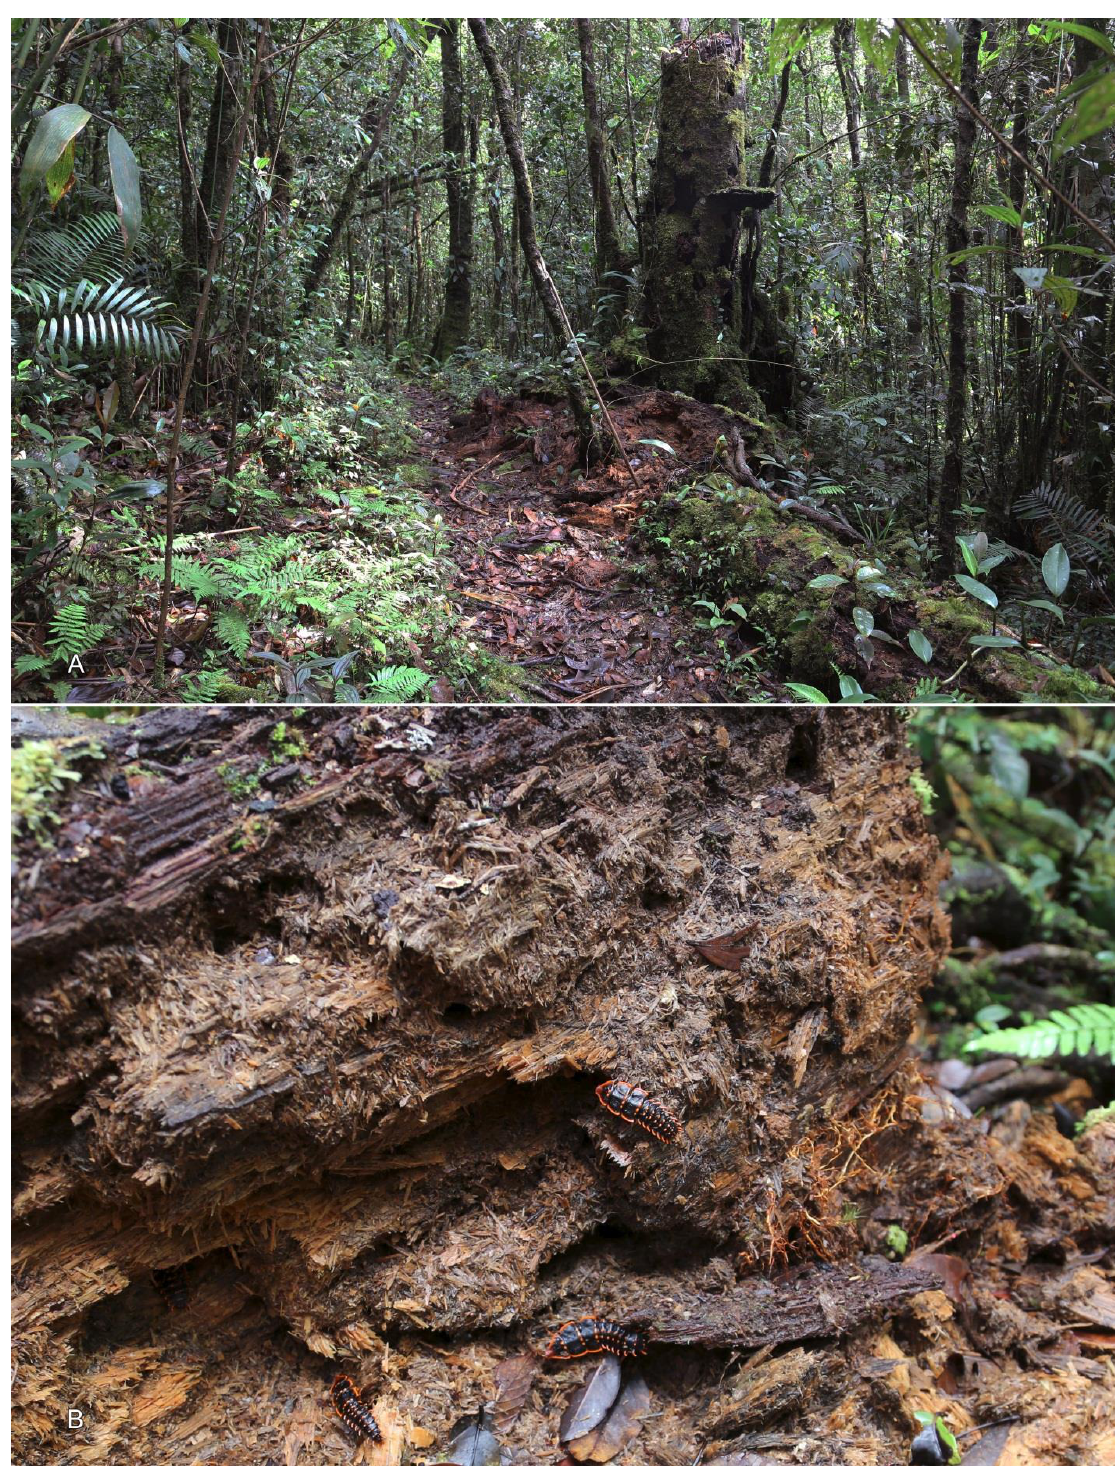
Figure 1. ( A ) — On a trail in the Crocker Range Mountains at 2000 m a.s.l., with a rotten stump and Platerodrilus larvae crawling at its base. ( B ) — A close-up on the Platerodrilus female larvae. Platerodrilus svetae Kazantsev, 2009: 56.